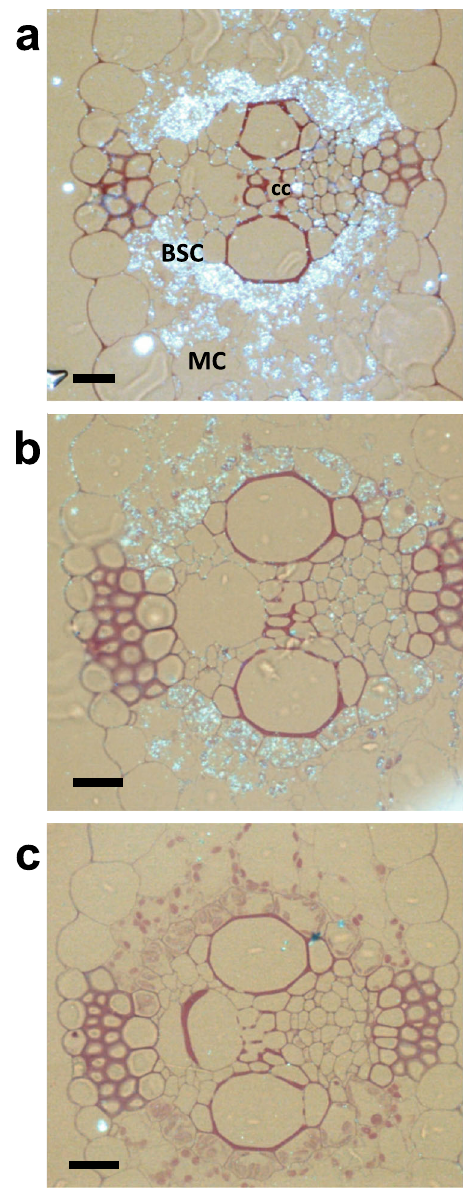
Fig. 2 Histological immunolocalization of GS in transverse leaf sections of a transgenic maize hybrid overexpressing Gln1-3 under the control of the CsVMV and maize RbcS promoters. Sections were examined under bright- fi eld epipolarized light. a Immunolocalization of GS in the leaf of a transgenic hybrid overexpressing Gln1-3 under the control of the CsVMV and of the maize RbcS promoters (hybrid line H27). b Immunolocalization of GS in untransformed hybrids. c Control section treated with preimmune serum. BSC bundle sheath cell; cc phloem companion cells; MC mesophyll cell. Bars = 100 µ